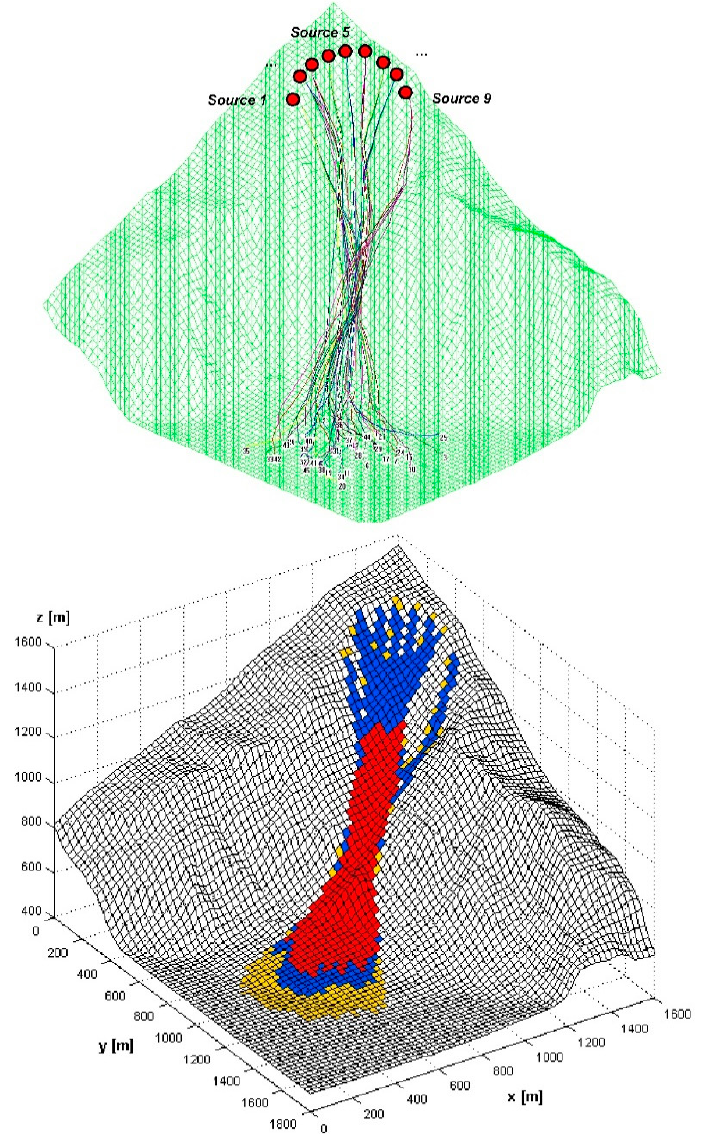
Figure 15. Top : geometry used for the channel-type topography problem and overview on the rock fall paths predicted by EBOUL. Bottom : hazard zoning for the scenario assumed, performed by